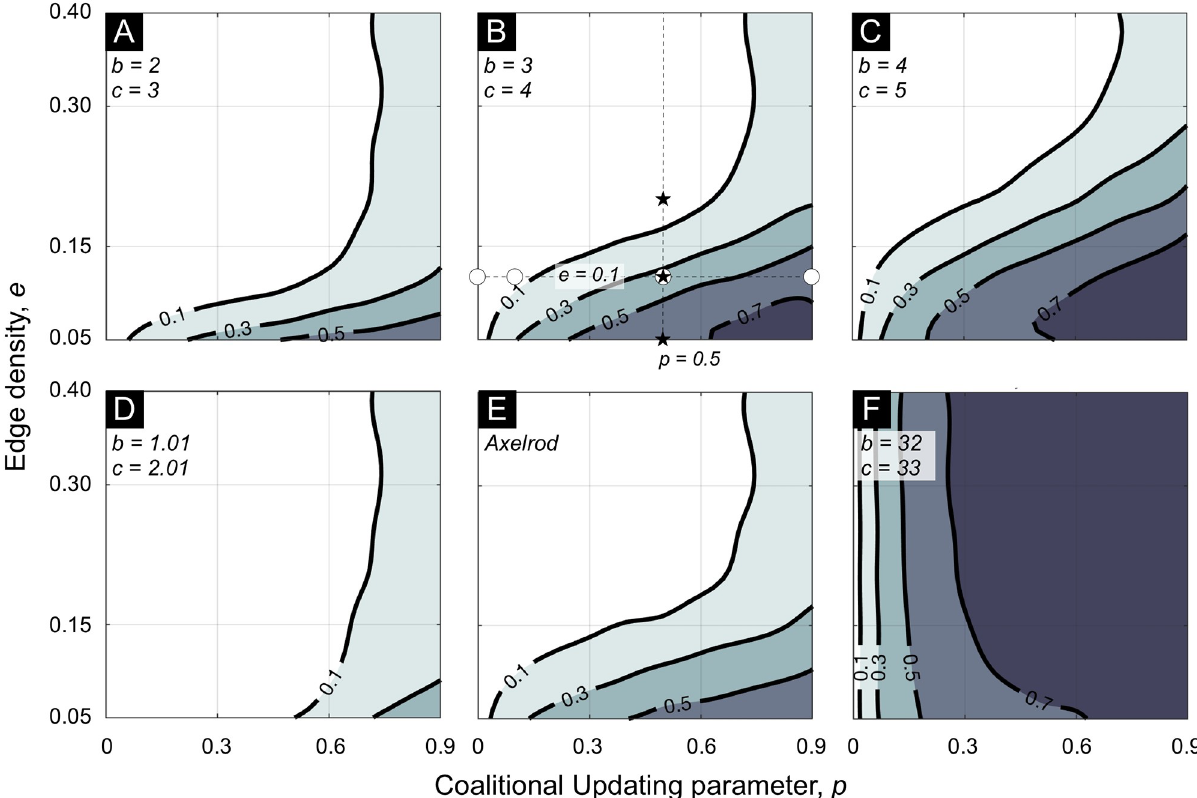
Fig 2. Cooperation by level of collaboration and interaction structure. Contours and shading indicate average share of cooperation in the population over updates 2, 501 to 3, 000 of the model run over each of 50 different random graphs, for given edge density e and collaboration parameter p . Panels A – D , and F present simulation outcomes at indicated values of b and c (see Table 1). Benchmark conditions are given in panel B: circle and star markers indicate positions in ( p , e ) space at which experiments reported in Fig 3 (circles) and Fig 4 (stars) are run. Simulation results under the payoffs of [9] (i.e. payoffs 3, 0, 5, 1) are presented in panel E for comparison. Panel D presents the boundary case in which an individual will only collaboratively switch from Defect to Cooperate if all of his neighbors will play Cooperate after the switch. Panel F presents the boundary case in which an individual will always collaboratively switch from Defect to Cooperate if at least one of his neighbors switches with